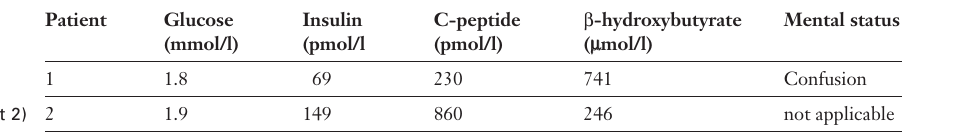
Laboratory values and symptoms after 48 hours (patient 1) and 11 hours (patient 2) at the end of fast- ing Screening for sul- fonylurea in plasma was negative in both